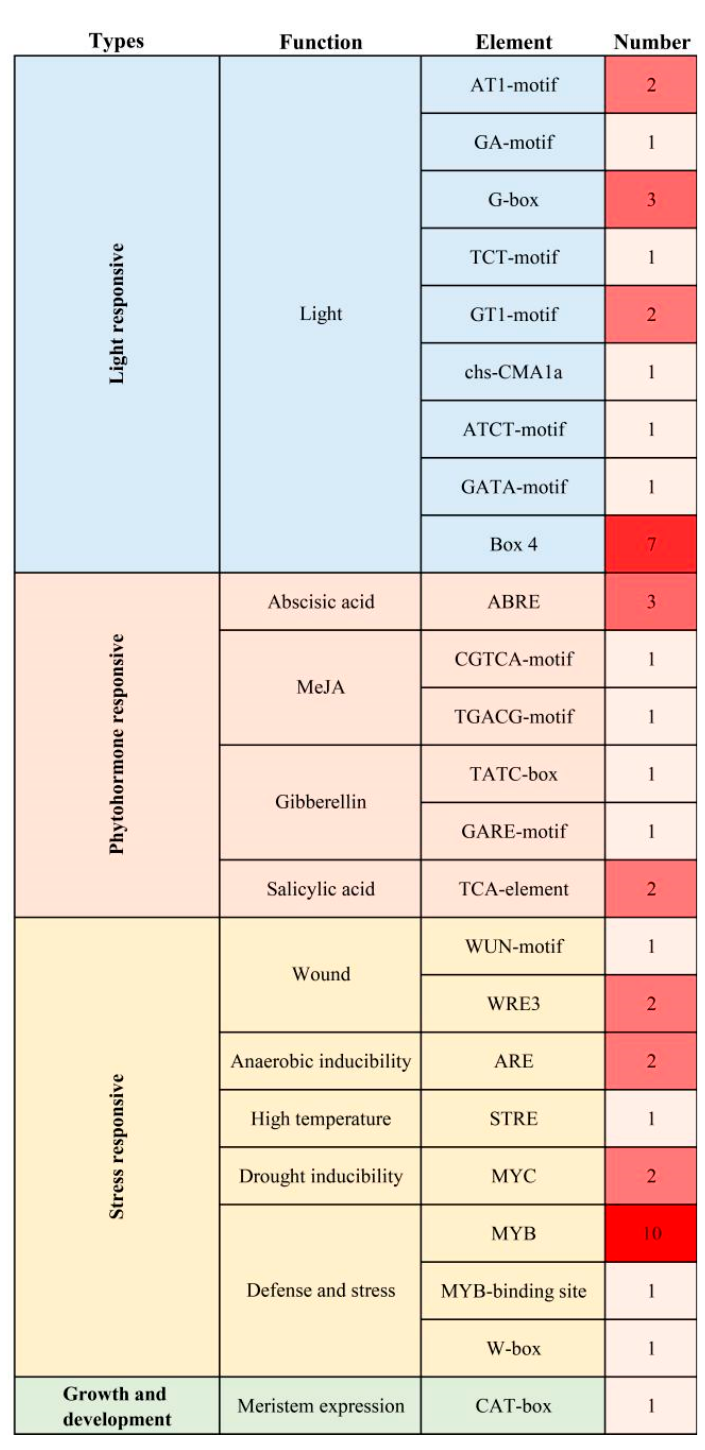
Figure 2. Cis -acting elements identified in the Citrus clementina RIN4 promoter. According to the annotated functions of the identified elements, cis -elements were mainly divided into four types, including light responsive, phytohormone responsive, stress responsive and growth and development related. The numbers represent the abundances of identified cis -elements in the RIN4 promoter, and the redder the color, the higher the abundance.